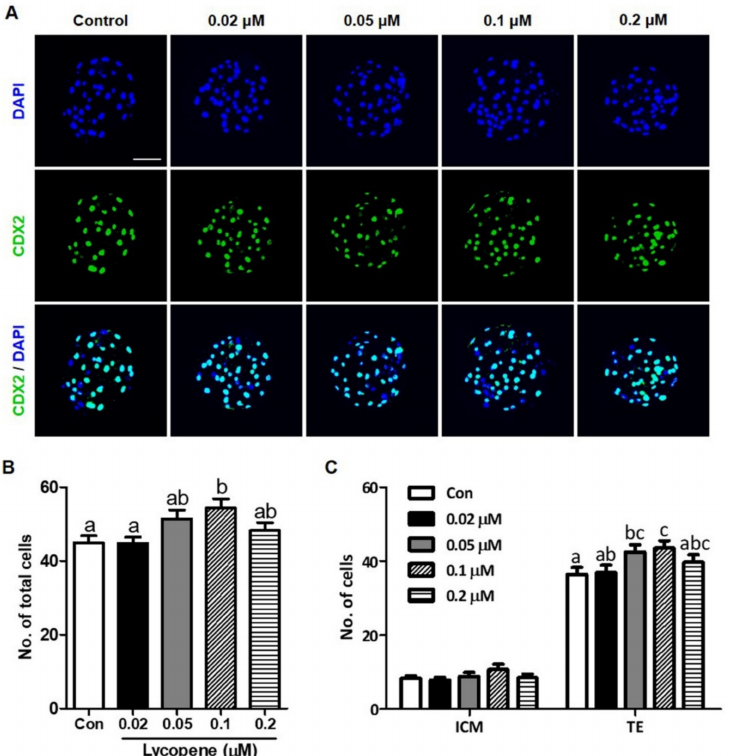
Figure 2. Effect of lycopene on ICM, TE ratio, and total cell number of porcine IVF embryos. ( A ) Representative images of differential staining of Day-6 IVF blastocysts treated with various concen- trations (0.02, 0.05, 0.1, and 0.2 µ M) of lycopene. ( B ) Total cell number and ( C ) ICM and TE ratio of blastocysts in the indicated groups. Different superscript letters (a–c) represent the significant differ- ence ( p < 0.05). Bar = 100 µ M. Abbreviations: ICM, inner cell mass; TE, trophectoderm; IVF, in vitro fertilized; DAPI, 4 (cid:48) ,6-diamidino-2-phenylindole; CDX2, caudal type homeobox 2; Con,